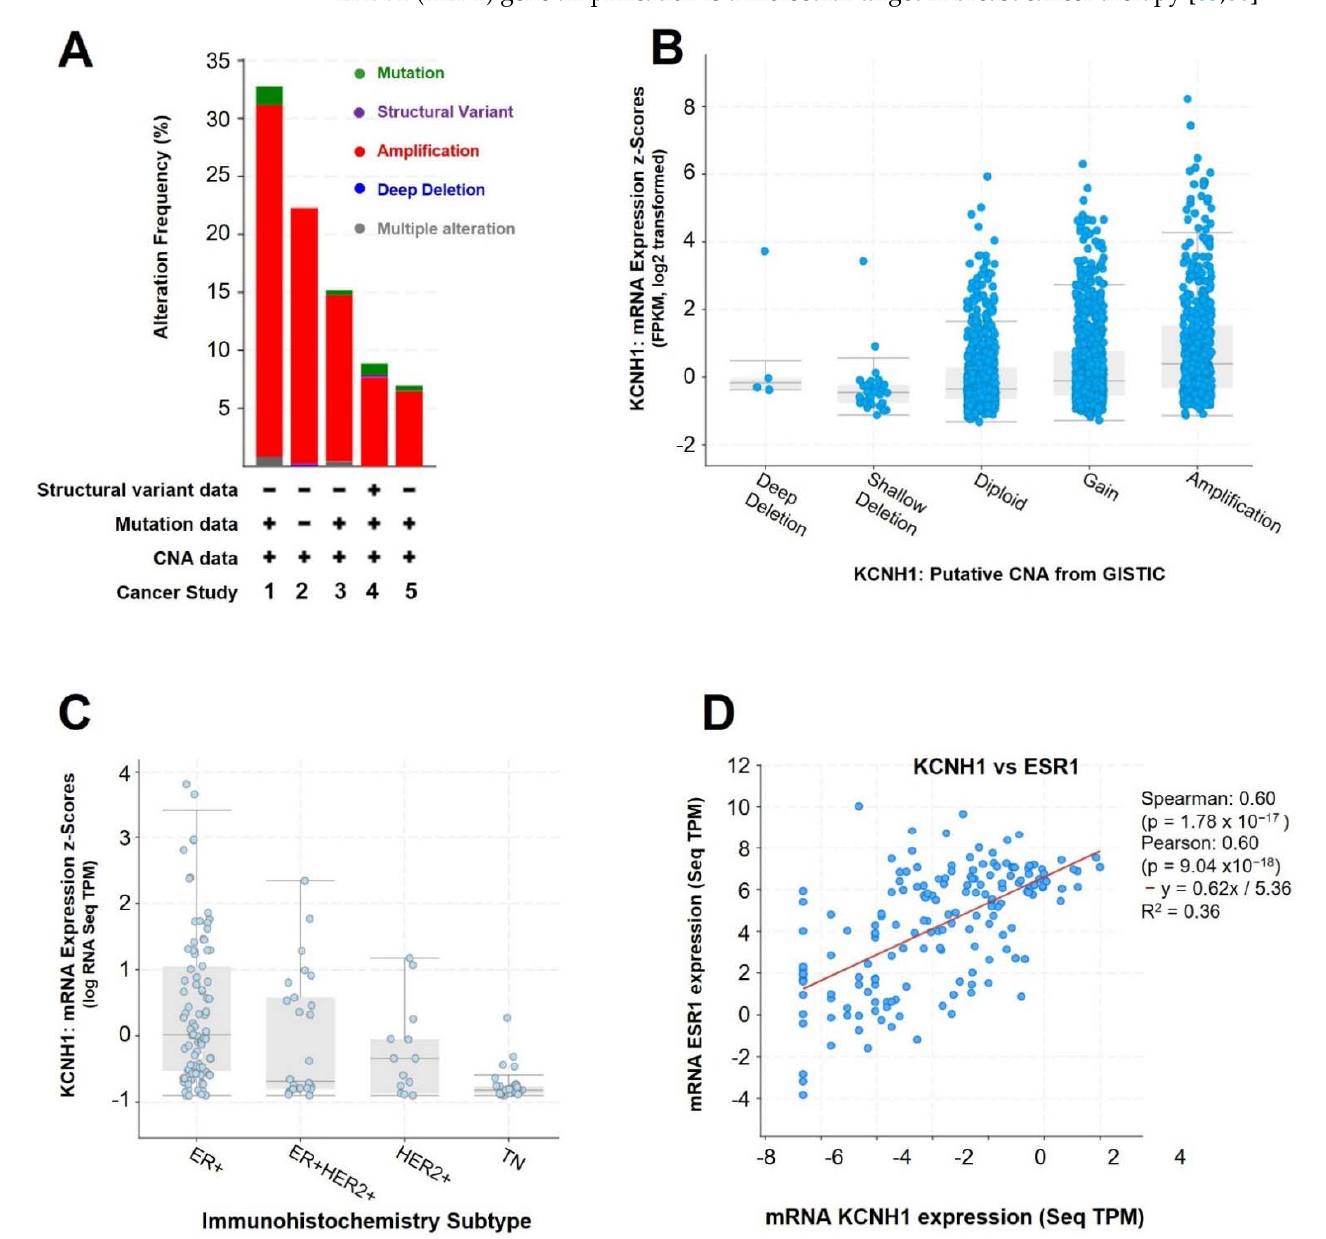
Figure 3. Genetic profile of KCNH1 gene in breast cancer using cBioPortal. ( A ) Summary of genomic alteration frequency of KCNH1 gene in five studies (1: CPTAC, Cell 2020; 2: METABRIC, Nature 2012 & Nat. Commun. 2016; 3: Provisional, February 2020; 4: TCGA, PanCancer Atlas; 5: INSERM, PLoS Med 2016). ( B ) Relative expression levels as a function of relative copy number of KCNH1 gene (Breast invasive carcinoma, TCGA, PanCancer Atlas). ( C ) Relative expression levels as a function of the immunohistochemistry subtype of breast cancer (Breast Cancer, SMC 2018). ( D ) Copy ‐ number alterations (CNA), fragments per kilobase of transcript per million fragments mapped (FPKM), ge ‐ nomic identification of significant targets in cancer (GISTIC), sequencing transcript per million (Seq TPM), variants of uncertain significance (VUS). 4. Hallmarks of Cancer and Kv10.1 Expression An emerging research area is concerned with the role of ion channel expression and its implication beyond their classical functions as action potential generators or players in neuronal communication [53,54]. In this way, numerous reports have shown that ectopic ion channel’s expression impacts cancer’s hallmarks and thus the disease progression [8].